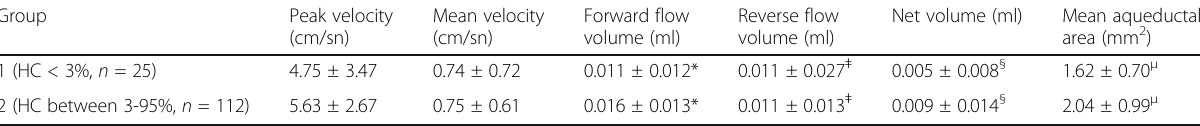
Table 3 Phase contrast MRI parameters in children with head circumference (HC) < 3% and HC between 3-95%